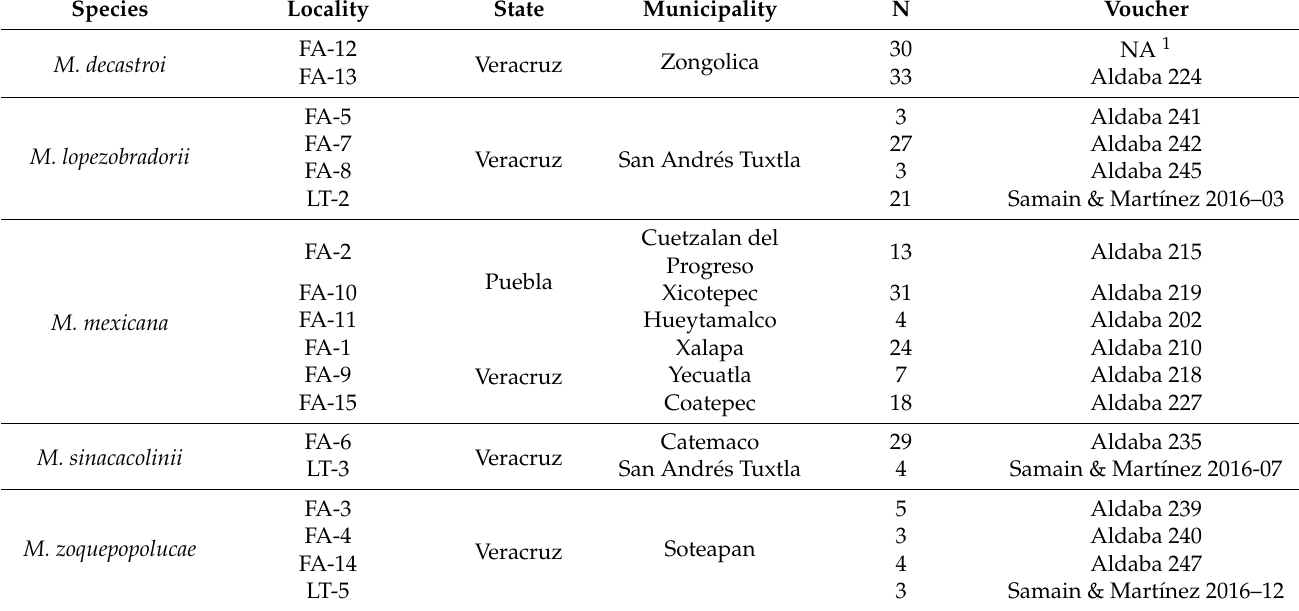
Table 5. Details of the localities collected for each species for Magnolia in the states of Puebla and Veracruz, Mexico. Locality coordinates have been omitted because of conservation concerns but can be obtained from the corresponding author. Voucher specimens will be deposited in the herbaria IEB, MEXU, and XAL (acronyms are according to [86]). 1 Locality was a seedling nursery. N: Sample